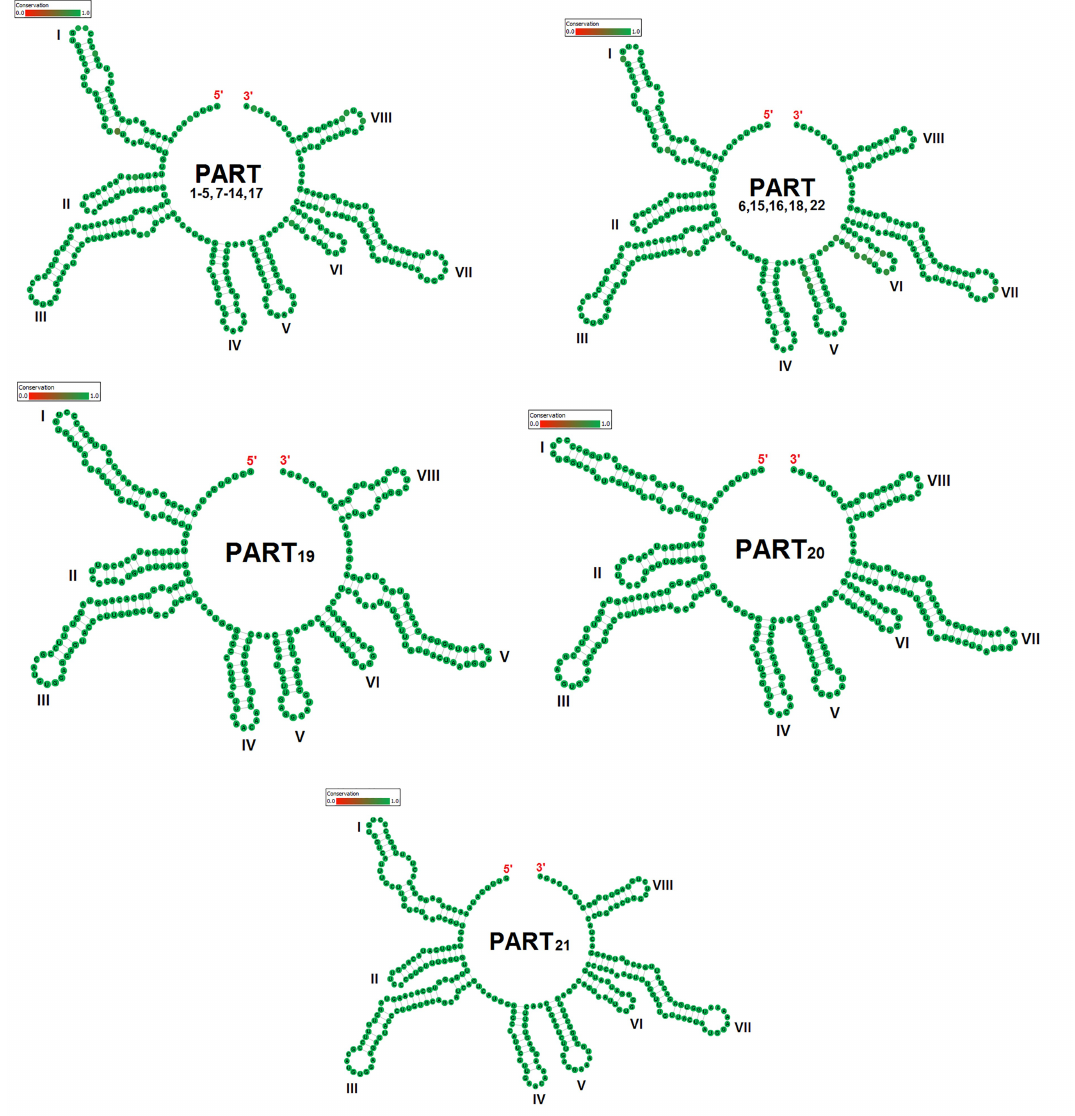
Fig. 5. Predicted secondary structure for partial ITS1 regions of parthenogenetic Artemia , based on four separated lineages by sequence-structure from profile neighbor-joining (See Fig. 4b). (Abbreviations of population are defined in Table